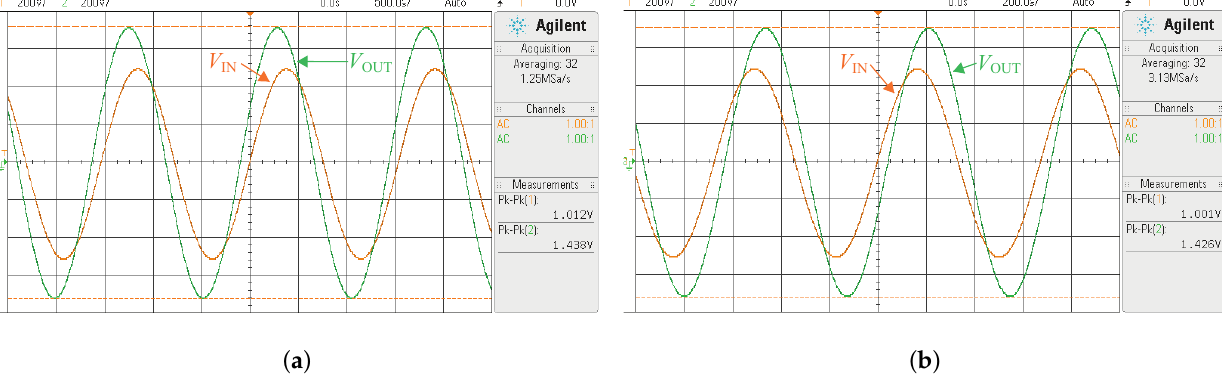
Figure 18. Input–output waveforms observed in oscilloscope for the proposed IBSPLF ( α = 0.5 ) with an input frequency of ( a ) f H,low = 650.3 Hz and ( b ) f H,high = 1.482